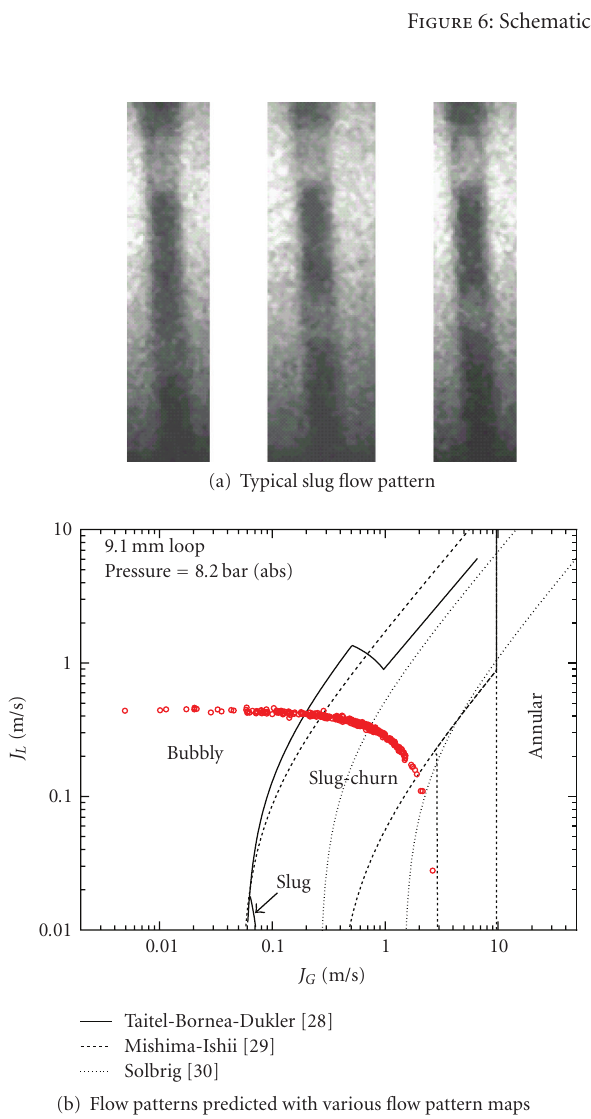
Figure 7: Flow patterns obtained for a typical run.